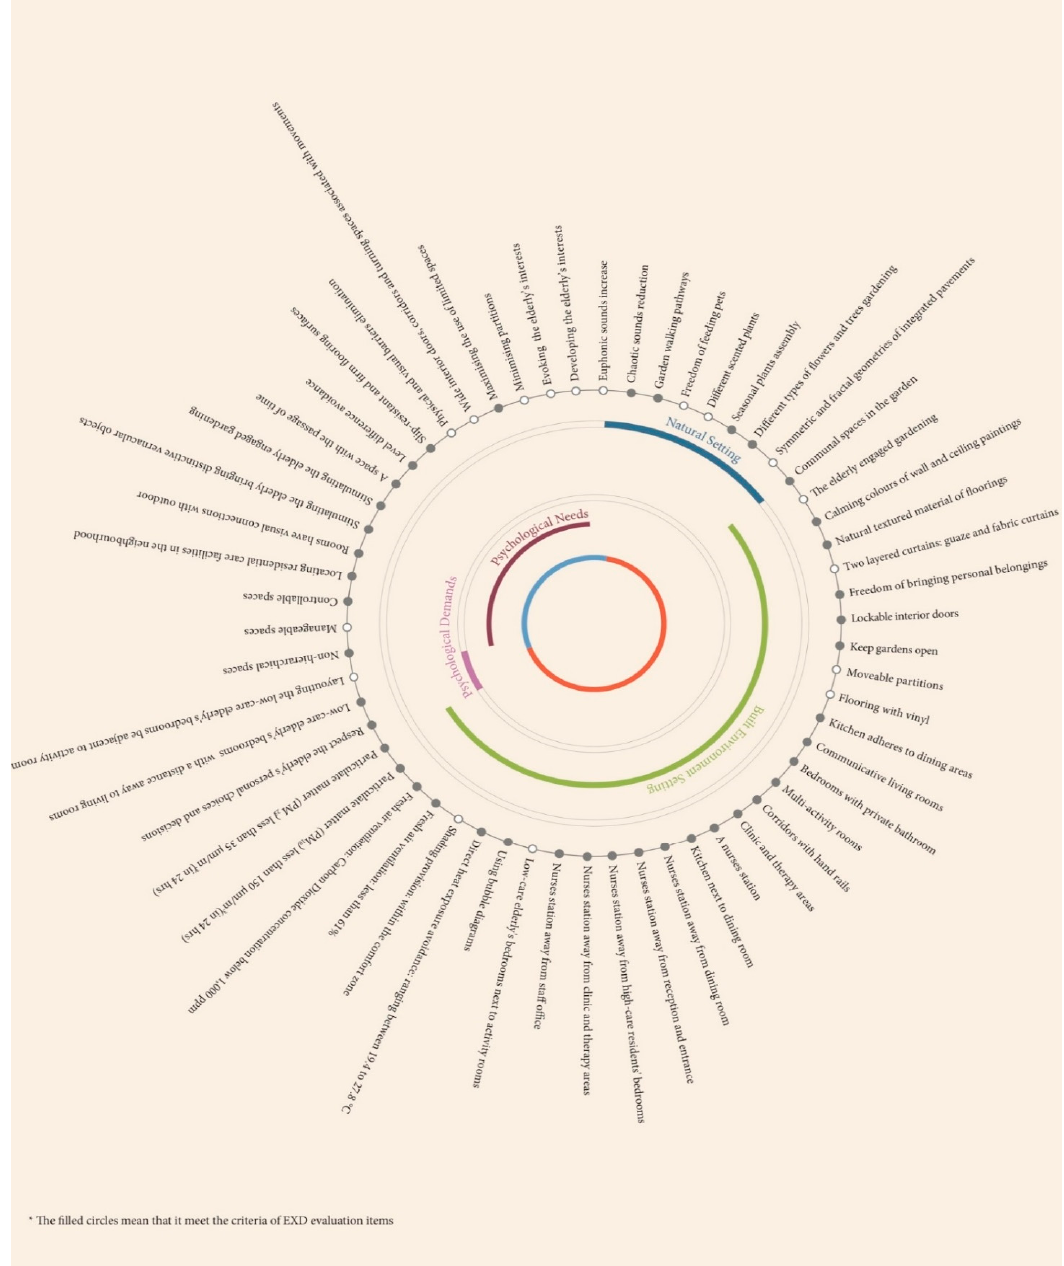
Figure 8. EXD human-environment relationship visualisation.